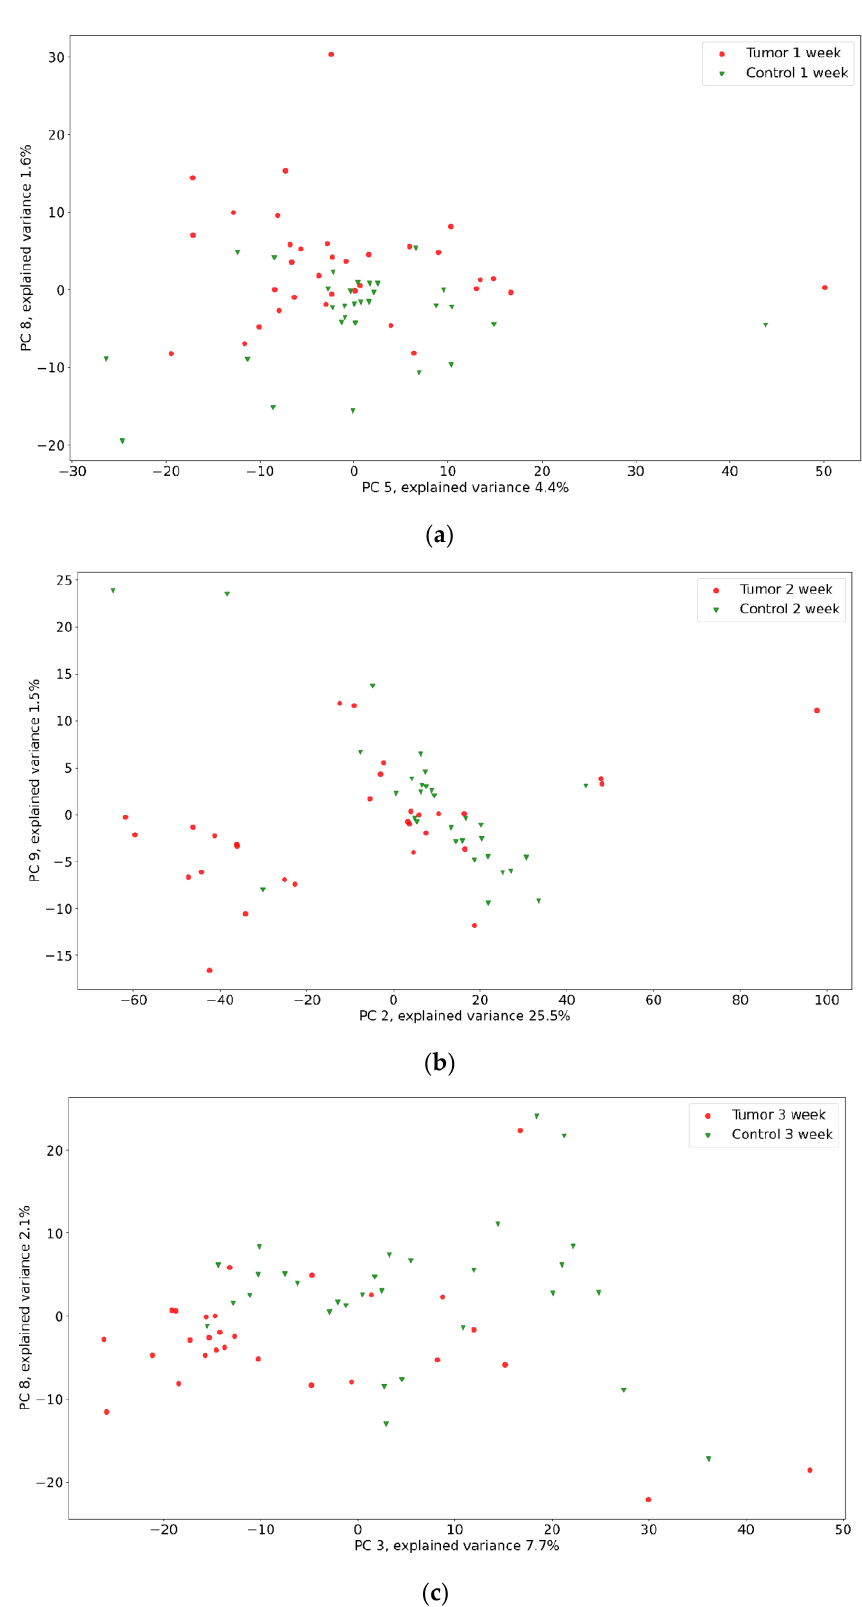
Figure 4. PCA method applied to Raman spectra of tumor and control groups for first ( a ), second ( b ), and third ( c ) weeks of the experiment.